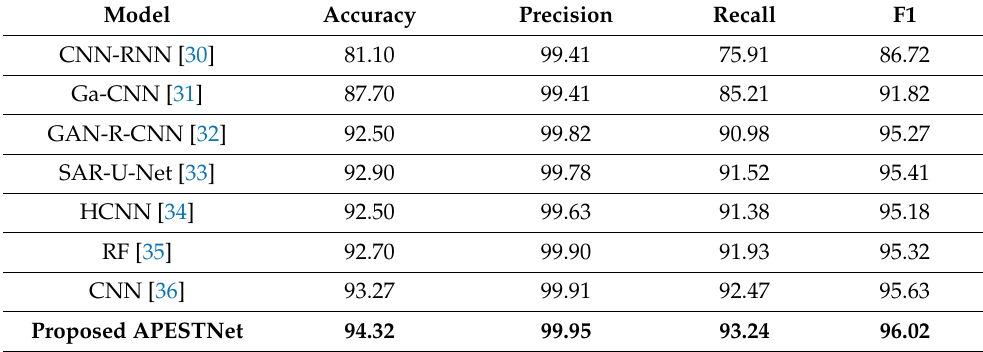
Figure 8. F1-measure Comparison for two data splits-ups. Table 4. Comparative Analysis of Proposed Model with existing techniques.